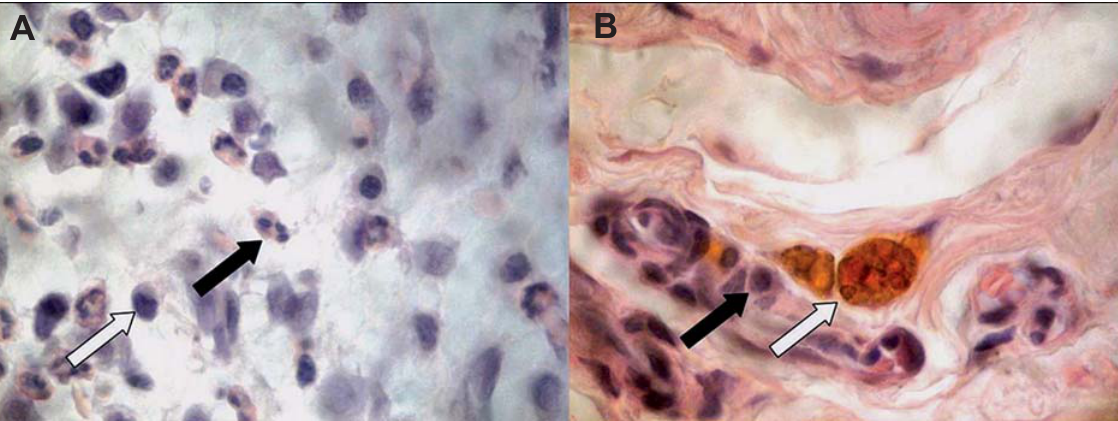
Figure 3 – (cid:3)(cid:36)(cid:12)(cid:3)(cid:44)(cid:81)(cid:192)(cid:68)(cid:80)(cid:80)(cid:68)(cid:87)(cid:82)(cid:85)(cid:92)(cid:3)(cid:70)(cid:72)(cid:79)(cid:79)(cid:86)(cid:3)(cid:76)(cid:81)(cid:3)(cid:87)(cid:75)(cid:72)(cid:3)(cid:74)(cid:85)(cid:68)(cid:73)(cid:87)(cid:72)(cid:71)(cid:3)(cid:68)(cid:85)(cid:72)(cid:68)(cid:3)(cid:20)(cid:24)(cid:3)(cid:71)(cid:68)(cid:92)(cid:86)(cid:3)(cid:68)(cid:73)(cid:87)(cid:72)(cid:85)(cid:3)(cid:86)(cid:88)(cid:85)(cid:74)(cid:72)(cid:85)(cid:92)(cid:3)(cid:16)(cid:3)(cid:81)(cid:72)(cid:88)(cid:87)(cid:85)(cid:82)(cid:83)(cid:75)(cid:76)(cid:79)(cid:3)(cid:11)(cid:69)(cid:79)(cid:68)(cid:70)(cid:78)(cid:3)(cid:68)(cid:85)(cid:85)(cid:82)(cid:90)(cid:12)(cid:3)(cid:68)(cid:81)(cid:71)(cid:3)(cid:80)(cid:82)(cid:81)(cid:82)(cid:81)(cid:88)(cid:70)(cid:79)(cid:72)(cid:68)(cid:85)(cid:3)(cid:79)(cid:72)(cid:88)(cid:78)(cid:82)(cid:70)(cid:92)(cid:87)(cid:72)(cid:3)(cid:11)(cid:90)(cid:75)(cid:76)(cid:87)(cid:72)(cid:3)